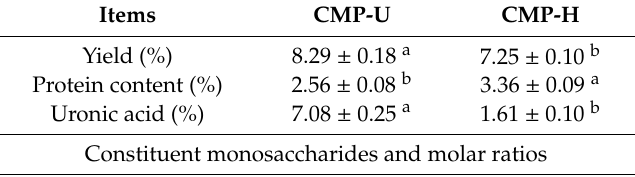
Table 3. Physicochemical properties of C. morifolium polysaccharides obtained by UAE and HRE.